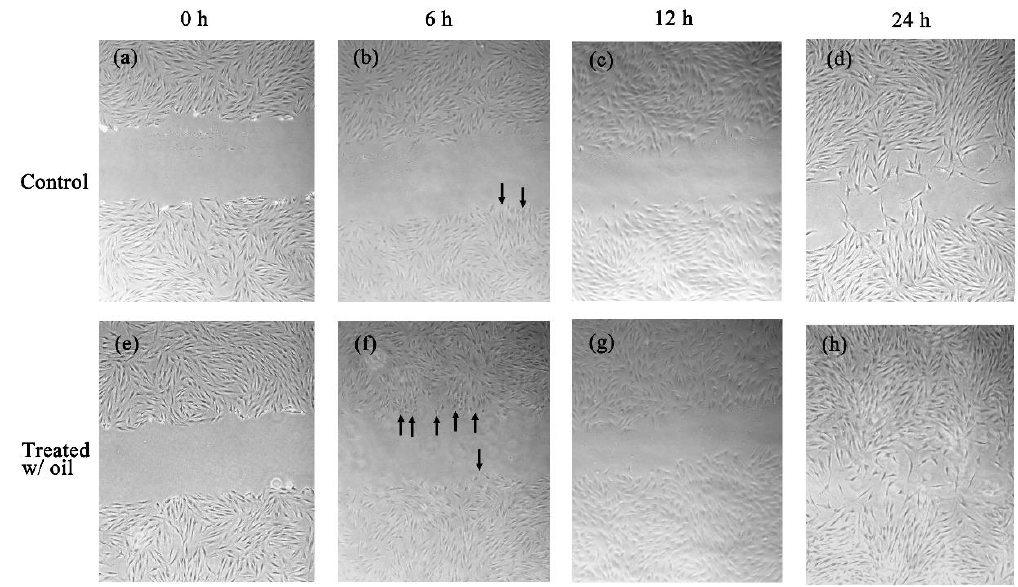
Figure 5. The control CCD-966SK cultured with S. mukorossi seed oil free medium at 0, 6, 12, and 24 h (a – d). S. mukorossi seed oil exhibits obvious effect on migration at 0, 6, 12, and 24 h (e – h) after incubation. The leading cells at the wound edge oriented toward the wound area 6 h after the scratch trauma was inflicted (black arrows).